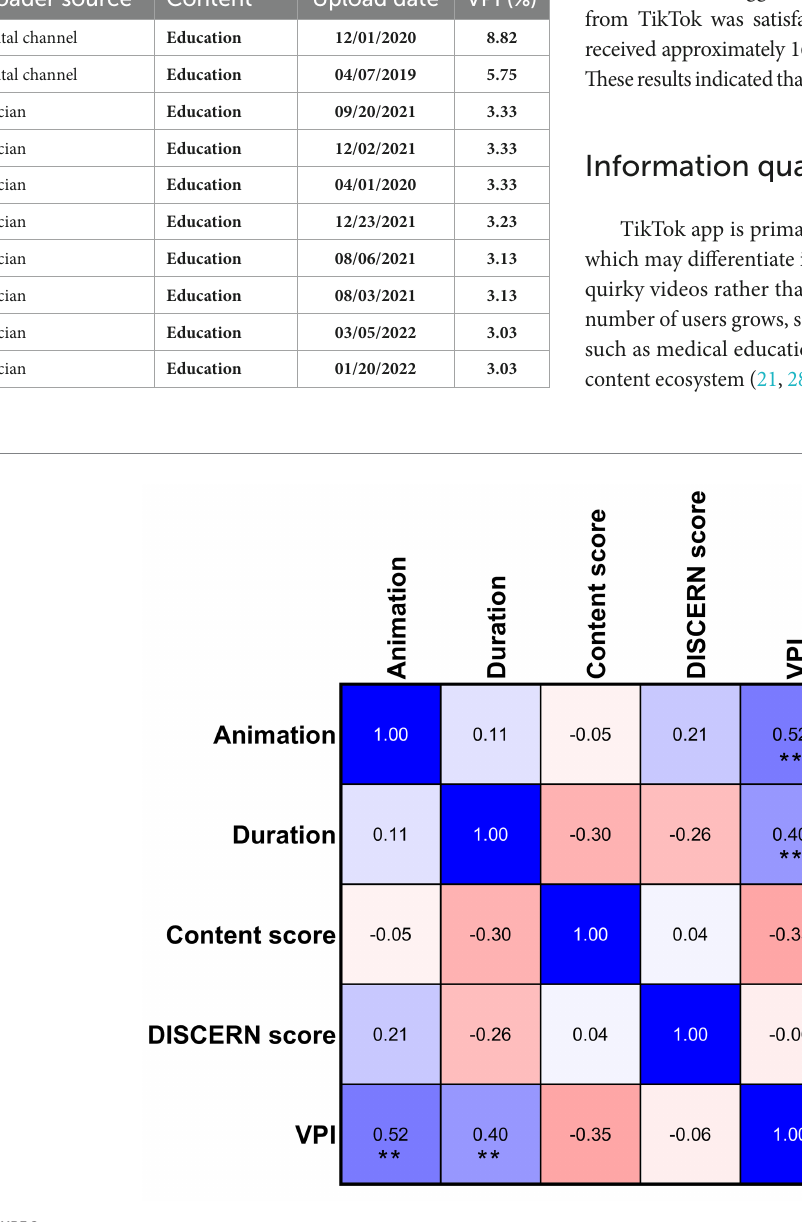
FIGURE 2 Correlations considering animation, duration, VPI, DISCERN scores, and content scores. ** p < 0.01.